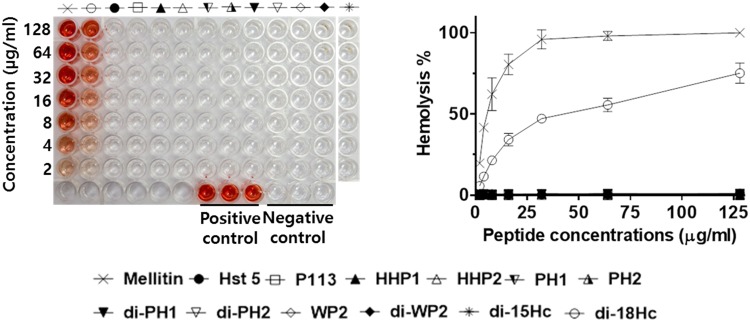
Hemolytic activities of Hst5, P113, di-18Hc, Halocidin-P113 hybrid peptides and control peptide.1% of triton-X100 was used as the control for 100% hemolysis and 0.01% acetic acid was used as the peptide-free control. Percent hemolysis was calculated with the following equation: Hemolysis (%) = (A540 of sample—A540 of peptide-free control) / (A540 of 100% control—A540 of peptide-free control) × 100.